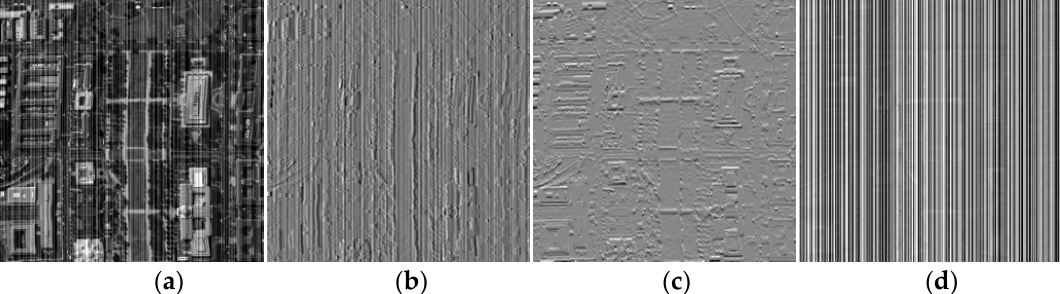
Figure 2. Statistics of non-zero elements in ∇ (cid:2870) 𝓢 . Vertical axis indicates the number of non-zero elements, while horizontal axis represents pixel value.